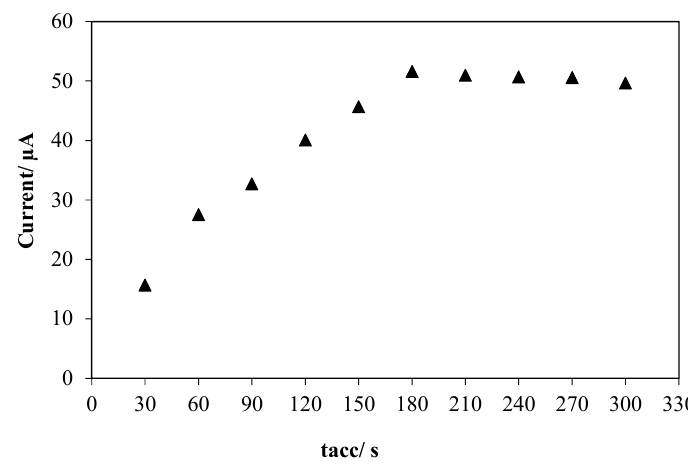
Figure 6. Effect of accumulation time on the oxidation peak current of Amoxicillin on the surface of AuNPs/en-MWCNTs/SPE. Amoxicillin, 10 µ M; Phosphate buffer, pH 7.0; Accumulation potential, − 0.4 V.